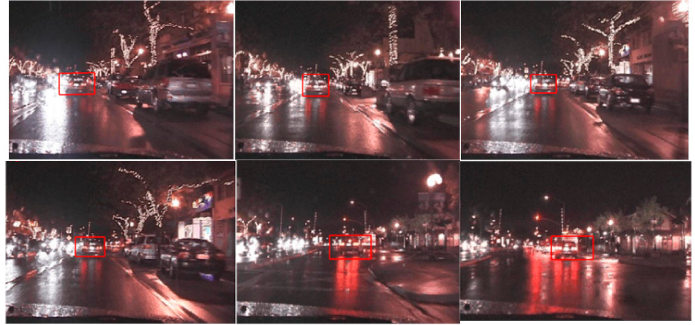
Figure 10. Tracking of Vehicle (Data Set: Vehicle at Night).